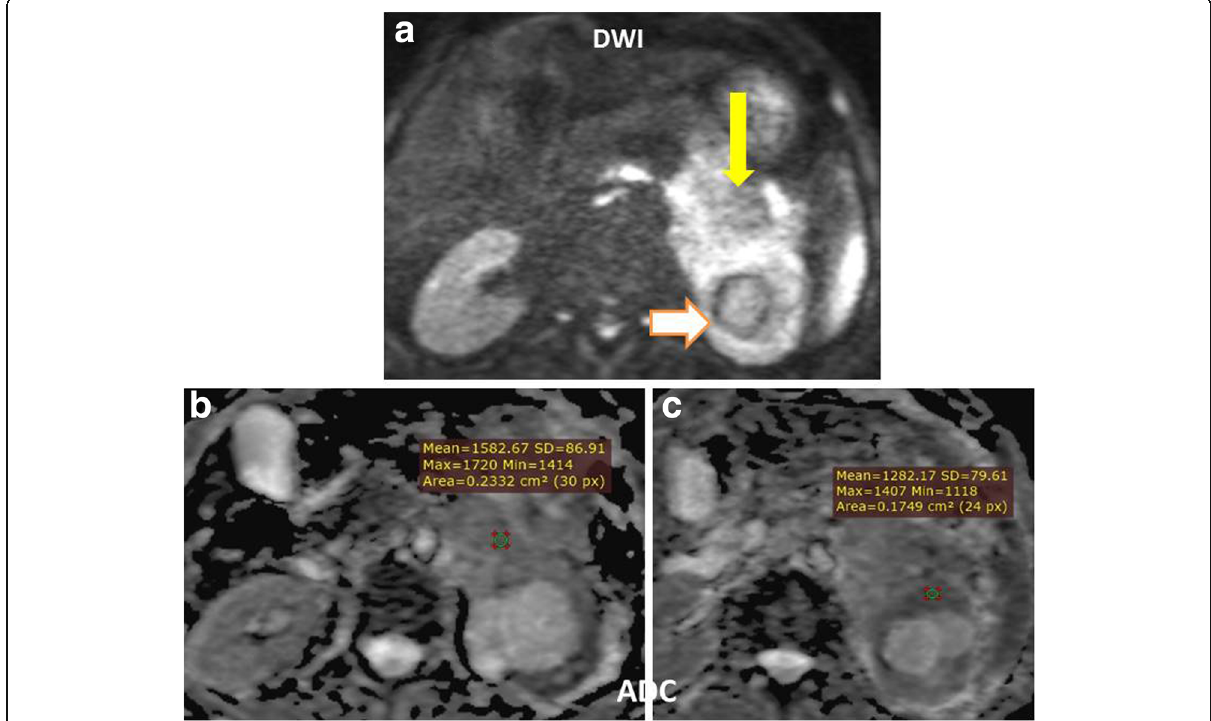
Fig. 2 A 67-year-old male patient comes complaining from left hypochondrial pain and swelling. a – c DWI and ADC maps showed truly restricted pancreatic tail lesion extending extra-pancreatic and inseparable from the left kidney. The average ADC value from this lesion was 1.2 – 1.5 × 10 − 3 mm 2 /s) (non-resectable